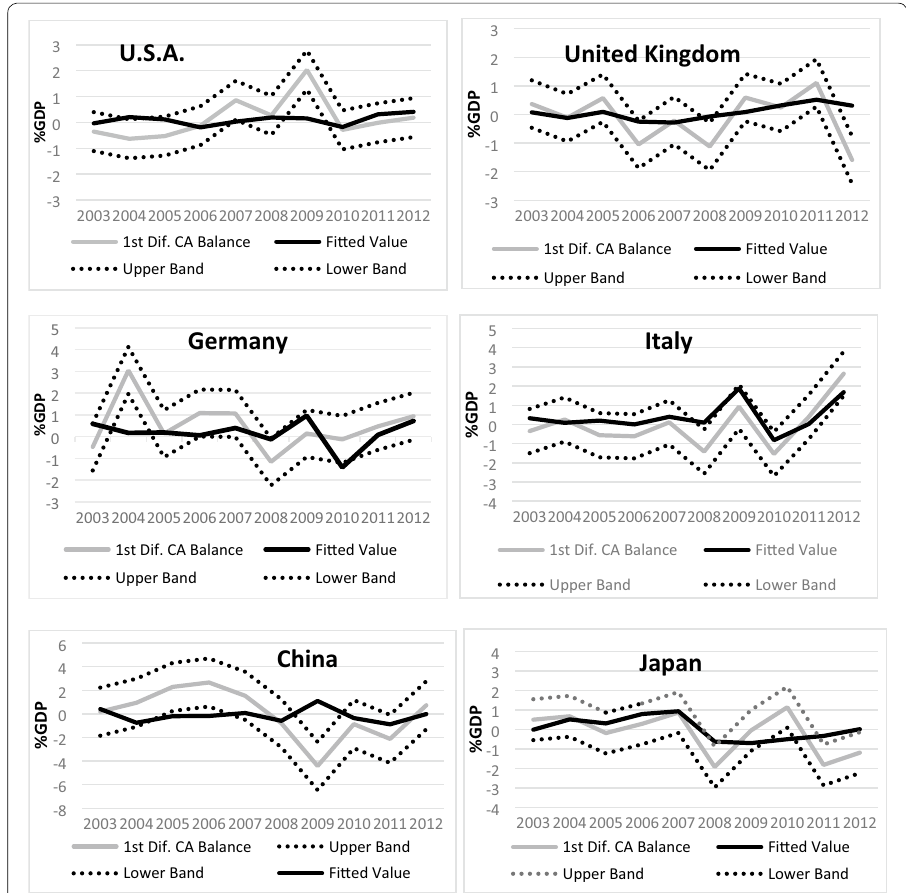
Fig. 1 Predicted first difference of current account balance with political stability and financial